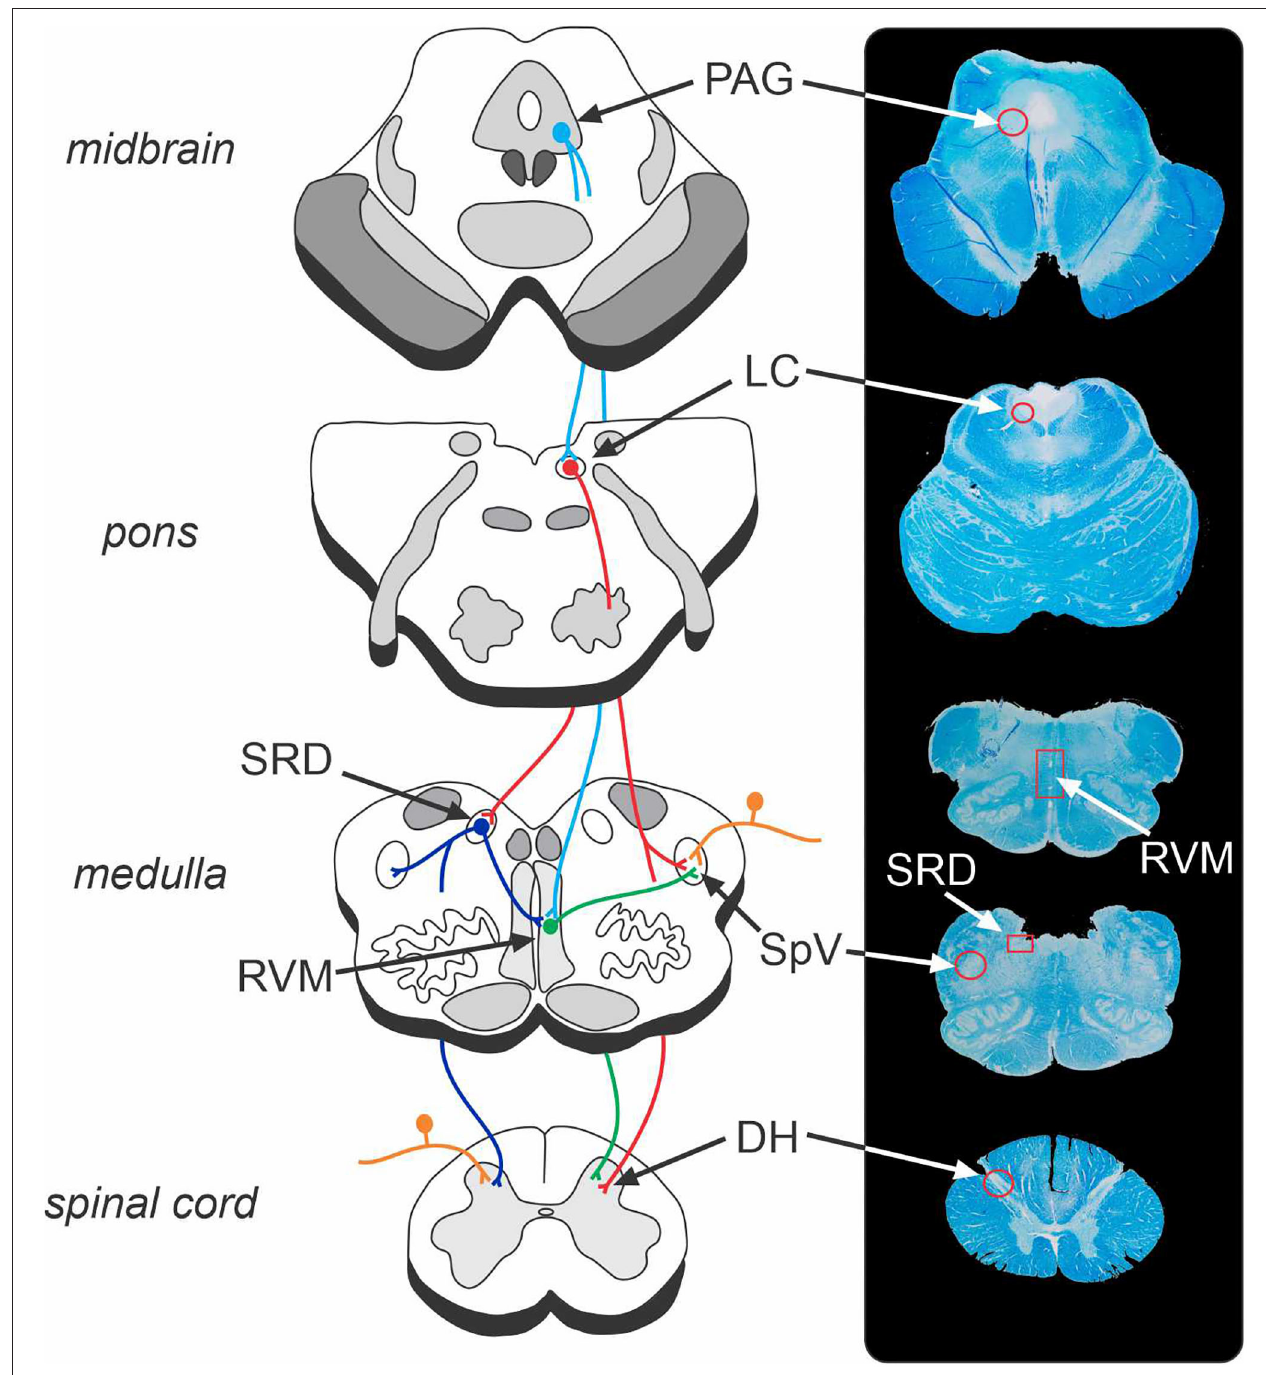
FIGURE 1 | Brainstem endogenous pain-modulation pathways and their corresponding location on a human brainstem histological specimen. The periaqueductal grey (PAG) – rostral ventromedial medulla (RVM) – dorsal horn (DH)/spinal trigeminal nucleus (SpV) pathway is a key system that can produce both analgesia and hyperalgesia. The locus coeruleus (LC) and subnucleus reticularis dorsalis (SRD) likewise send direct projections to the DH/SpV to modulate nociception. The endogenous pain-modulation sites are highly interconnected (for instance, LC-SRD projections and SRD-RVM projections) and thus act collectively to exert dynamic anti- and pro-nociceptive control over the primary nociceptive synapse. Orange, nociceptor afferent projections to DH and SpV; light blue, efferent projections from PAG; red, efferent projections from LC; green, efferent projections from RVM; dark blue, efferent projections from SRD. Note that corresponding structures exist